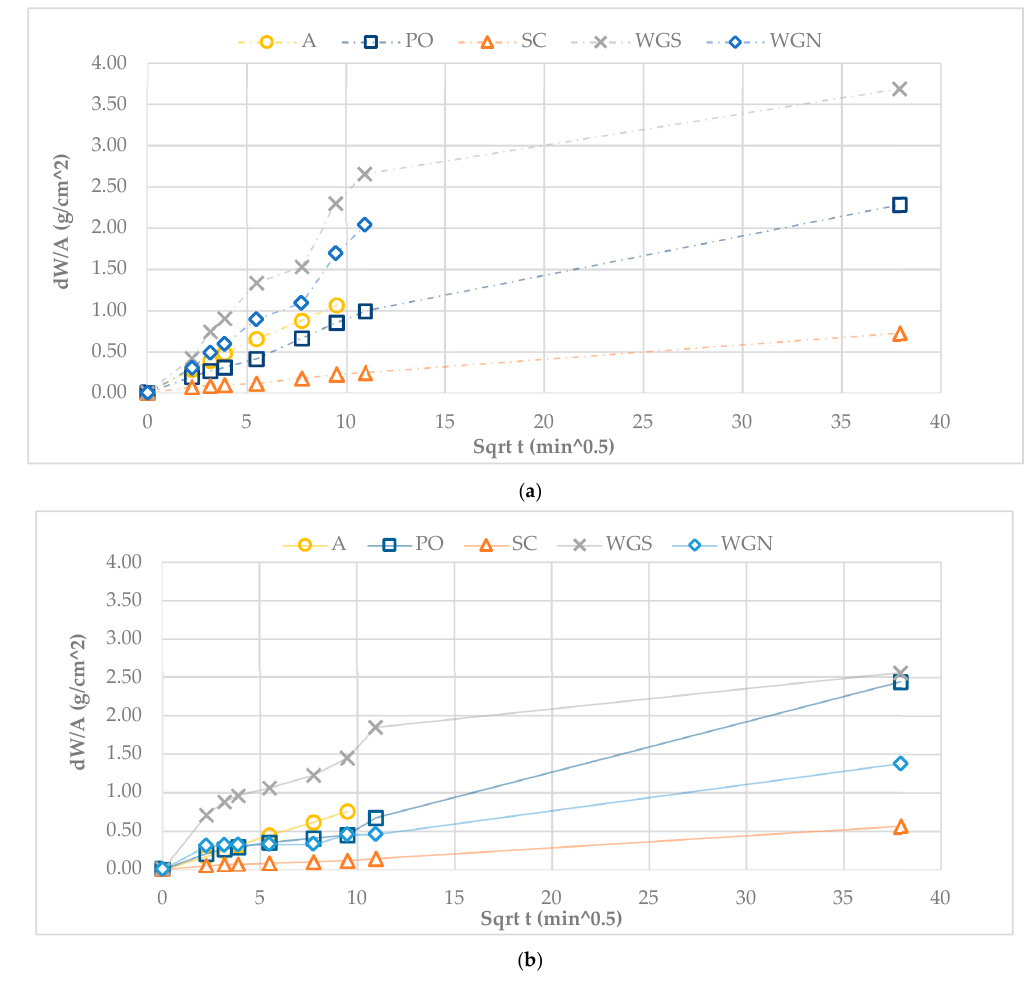
Figure 2. Capillary absorption of the mortars at ( a ) 180 days and ( b ) 365 days. Table 2. Physical properties of the mortars.